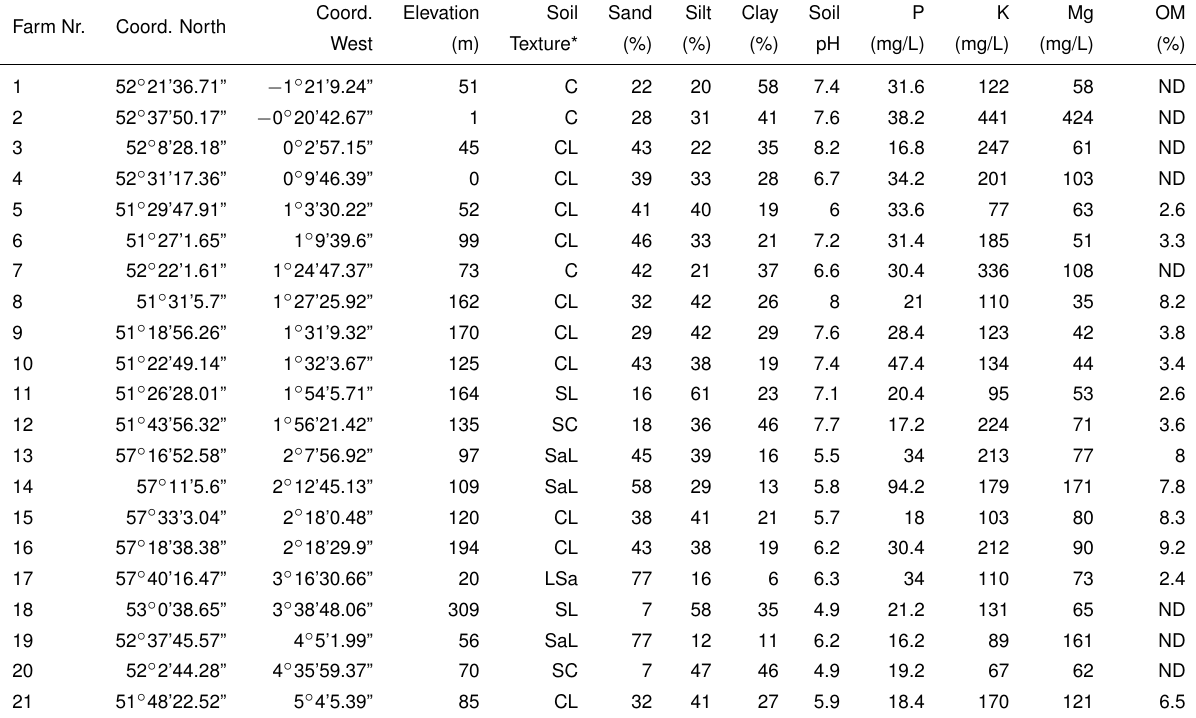
Table 3. Details of on-farm trials: Geographic coordinates and soil properties. Farm